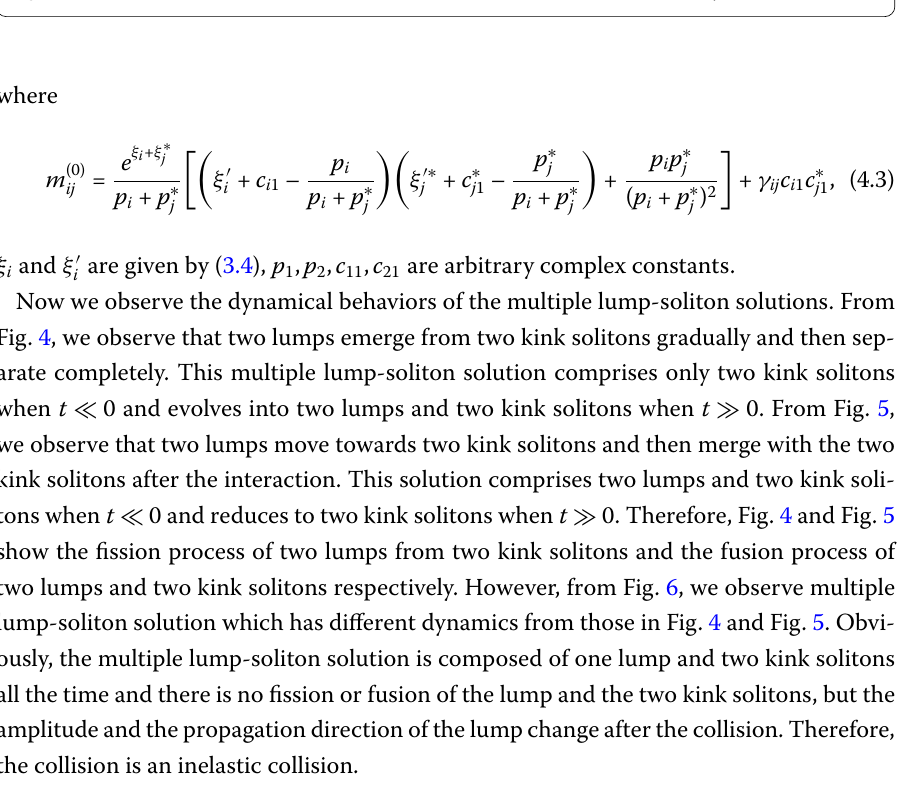
Figure 3 Plot of a lump and a kink soliton fusion with parameters p 1 = 0.4 + 0.5 i , c 11 = 1, γ 11 =